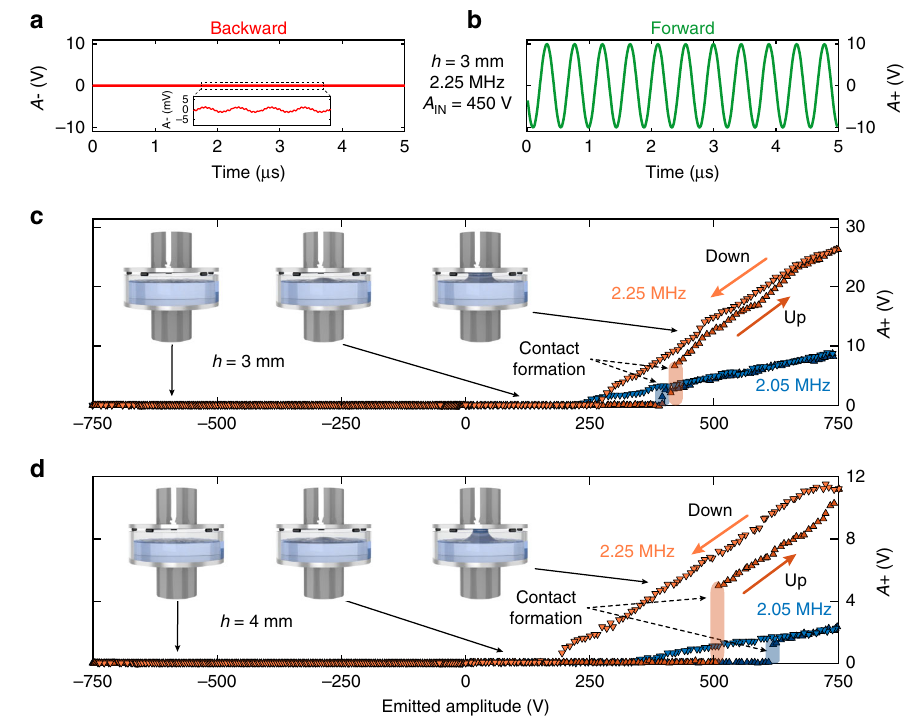
Fig. 2 Temporal signals and amplitude dependence. Transmitted amplitude A + for an excitation frequency of 2.25 MHz and input amplitude V in = 450 V, with an air layer thickness h a = 3 mm in: a backward and b forward directions. The inset in a is a close-up of the transmitted signal in the backward direction. c Transmitted amplitude in both the backward ( A − ) and forward ( A + ) propagation directions as a function of the emitted amplitude V in along a cycle of increasing and decreasing amplitudes, for two different excitation frequencies ( f 1 = 2.05 MHz and f 2 = 2.25 MHz) and two different air layer thicknesses: h a = 3 mm in c and h a = 4 mm in d . The diagrams in c , d illustrate the multilayer con fi guration at the indicated emitted amplitudes. The negative (positive) emitted amplitude horizontal scale corresponds to the peak-to-peak amplitude of the signal emitted in the backward (forward) direction,